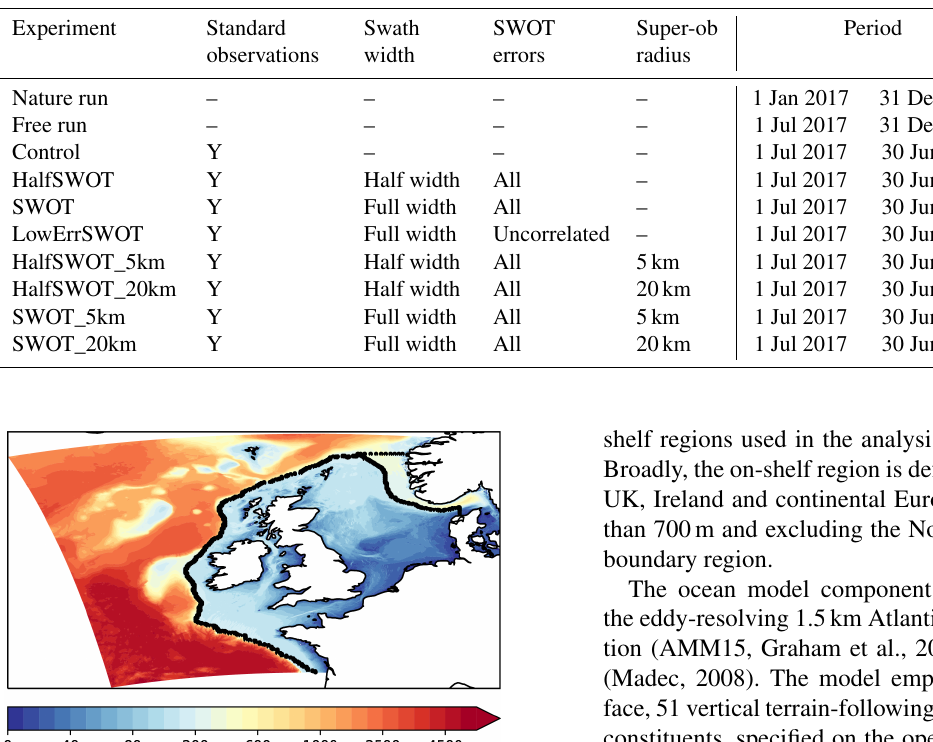
Table 1. Experimental setup.